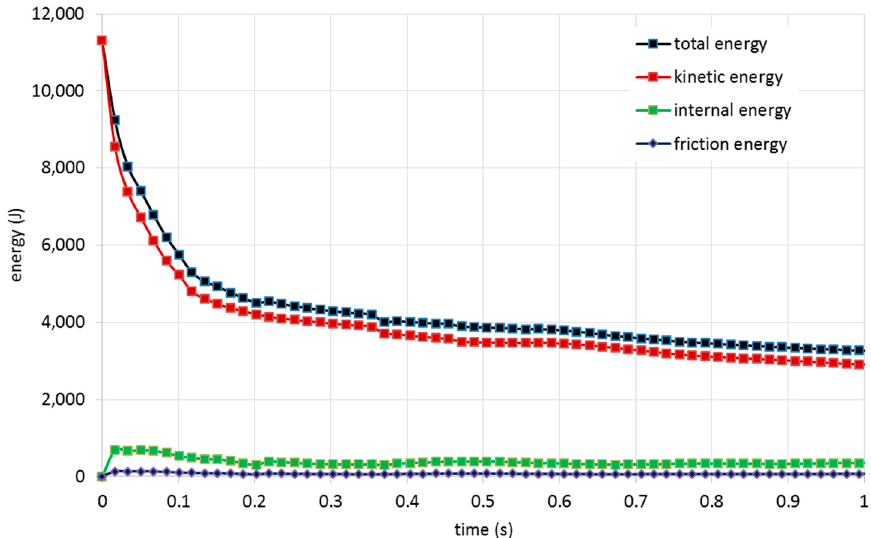
Figure 9. Energy balance representation for 3 mm PFCS panels subjected to 500 mm/min.